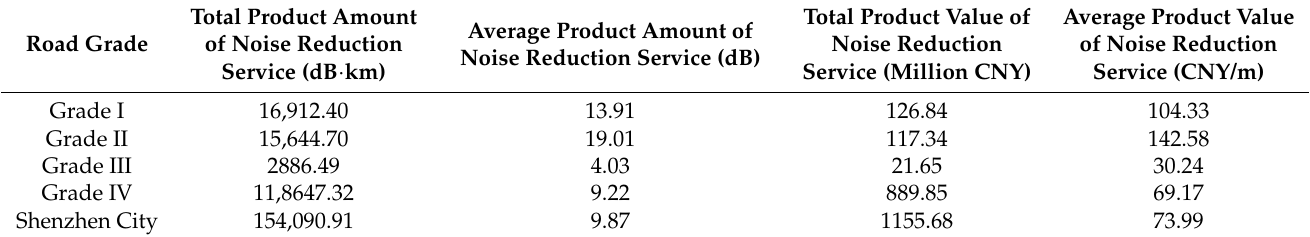
Table 1. Product amount and value of the noise reduction service provided by roadside green belts in Shenzhen and at each road grade.